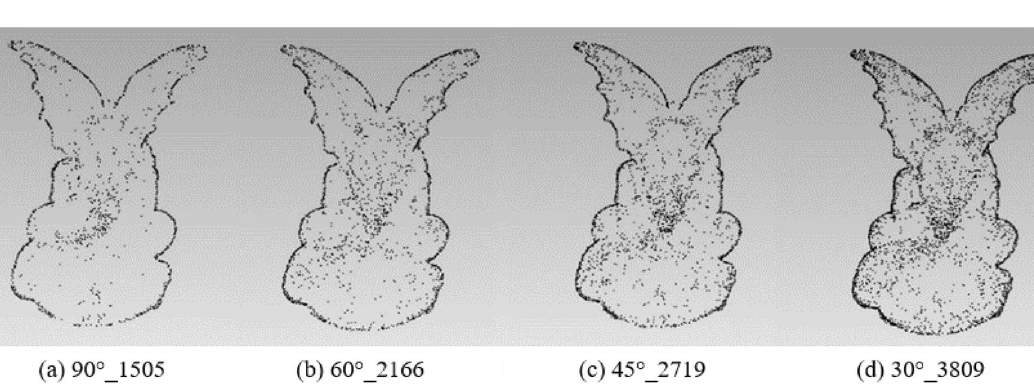
Figure 8. The point cloud with different numbers of feature points extracted with different angles for Gargo50k.